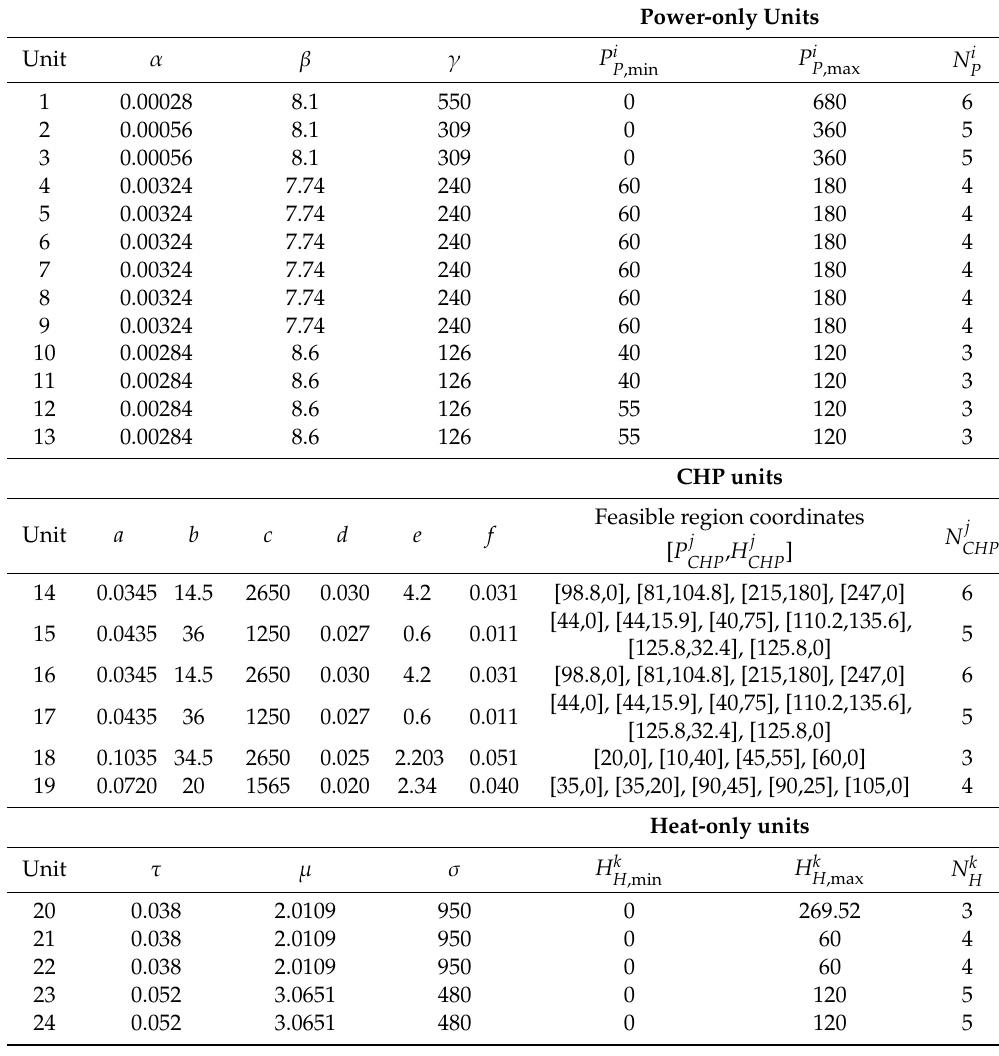
Table 13. Generation units’ data of the second syste m. Power-only Units